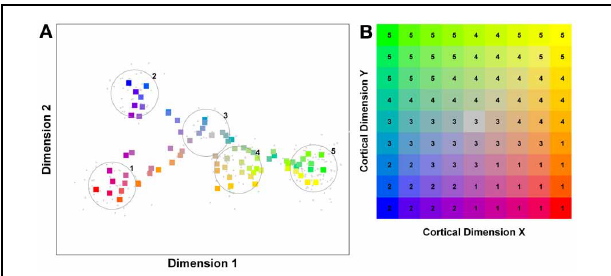
FIGURE 14 | Selectivity preferences for 81 neurons exposed to five object categories. The classifiers were subject to strong local lateral excitation ( h = 1), but otherwise the simulation parameters were identical to those shown in Figure 12 . Notice in this case that there is evidence for quite rigid structure in neural selectivity, i.e., object category and physical location are now closely related. (A) Neural selectivity within object space. (B) Neural selectivity across the cortical